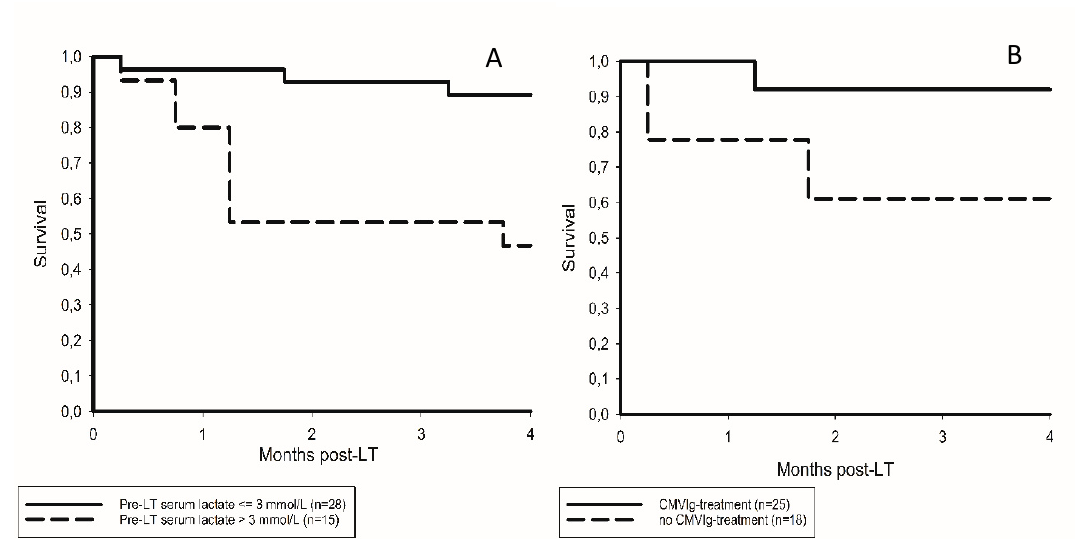
Figure 2. ( A ) Postoperative survival rates at 3 months were 92.9% and 53.3% in patients with pre-LT serum lactate levels ≤ versus >3 mmol/L, respectively, log rank = 0.002. ( B ) Survival rates in patients receiving and those not receiving CMVIg were 92% and 61.1%, respectively, log rank = 0.02.